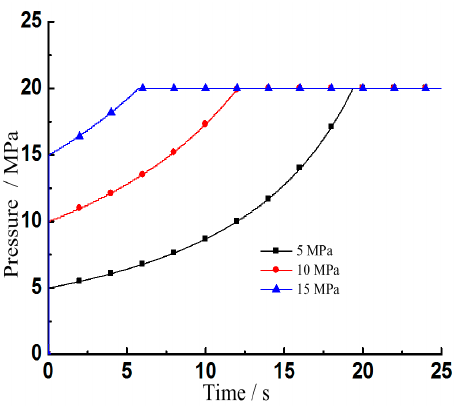
Figure 8. Compression of hydraulic accumulator (HA) pressure with different pre-charge pressures.